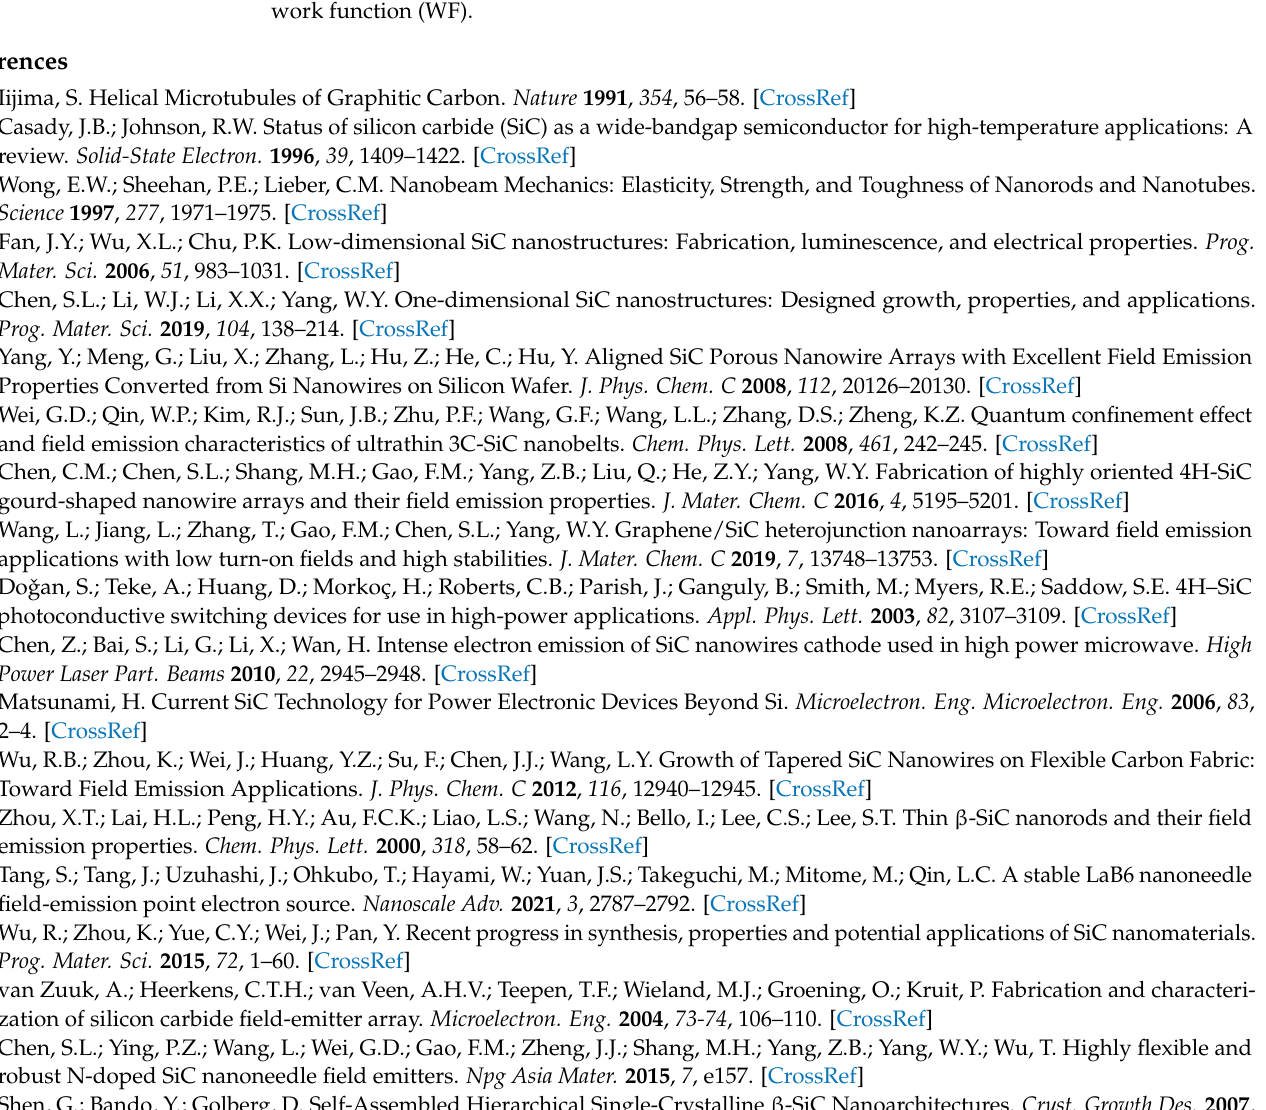
Figure A3. ( a ) Global spectrum of ultraviolet photoelectron spectroscopy. Left and right panel of ( b ) shows the secondary electron cut-off and the Fermi level regions, respectively, to determine the work function